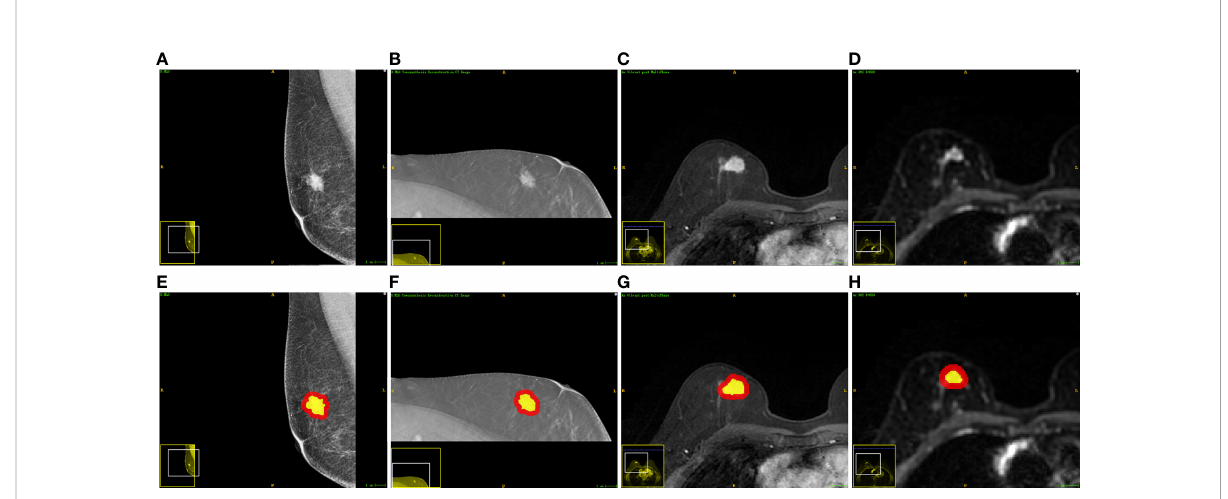
FIGURE 2 Examples of one patient who had invasive breast cancer and the segmented ROIs. From left to right: (A, E) the DM image, (B, F) the DBT image, (C, G) the DCE-MRI image, and (D, H) the DWI image. The yellow regions are the intratumoral ROIs. The red regions indicate the peritumoral